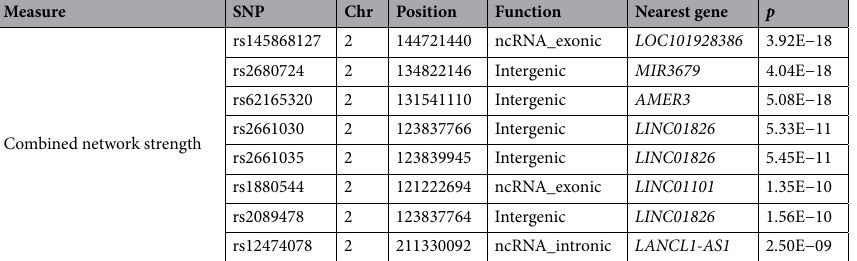
Table 2. Multivariate SNP-based analyses for combined network strength measure. Only results that survived Bonferroni correction ( p < 5 × 10 –8 /4 = 1.25 × 10 –8 ) are reported. Abbreviations: SNP, single nucleotide polymorphism; Chr, chromosome; ncRNA, non-coding RNA; LOC101928386 , Uncharacterized LOC101928386; MIR3679 , MicroRNA 3679; AMER3 , APC Membrane Recruitment Protein 3; LINC01826 , Long Intergenic Non-Protein Coding RNA 1826; LINC01101 , Long Intergenic Non-Protein Coding RNA 1101; LANCL1-AS1 , LANCL1 Antisense RNA 1.